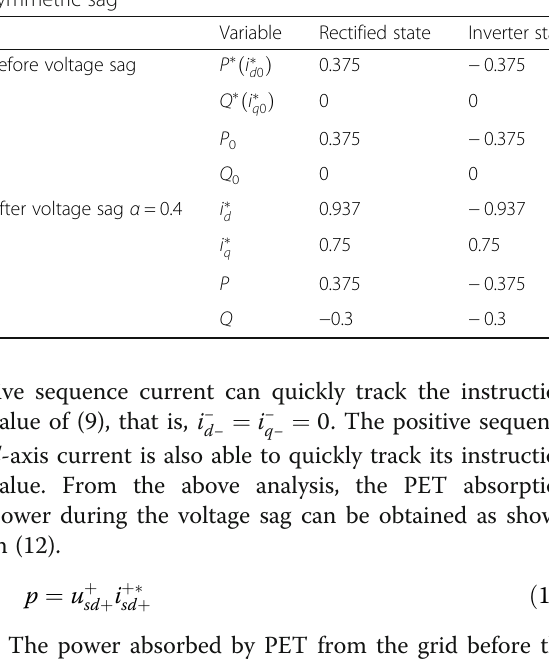
Table 2 Low voltage ride through variables of voltage